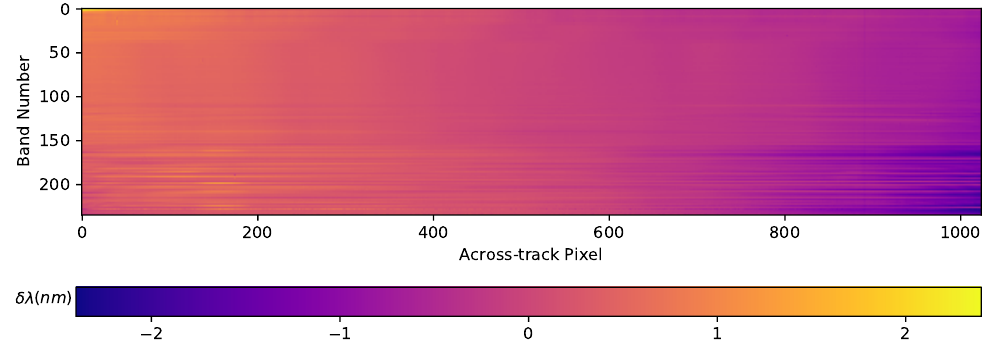
Figure 1. Quantification of the spectral smile on the DESIS focal plane as the difference of each detector element to the nominal band center wavelength. Lower bands are mostly dominated by a clocking effect between the grating plate and the focal plane. The NIR bands are also influenced by an etaloning effect, produced by reflections between sensor layers, leading to the appearance of interference patterns. 4.